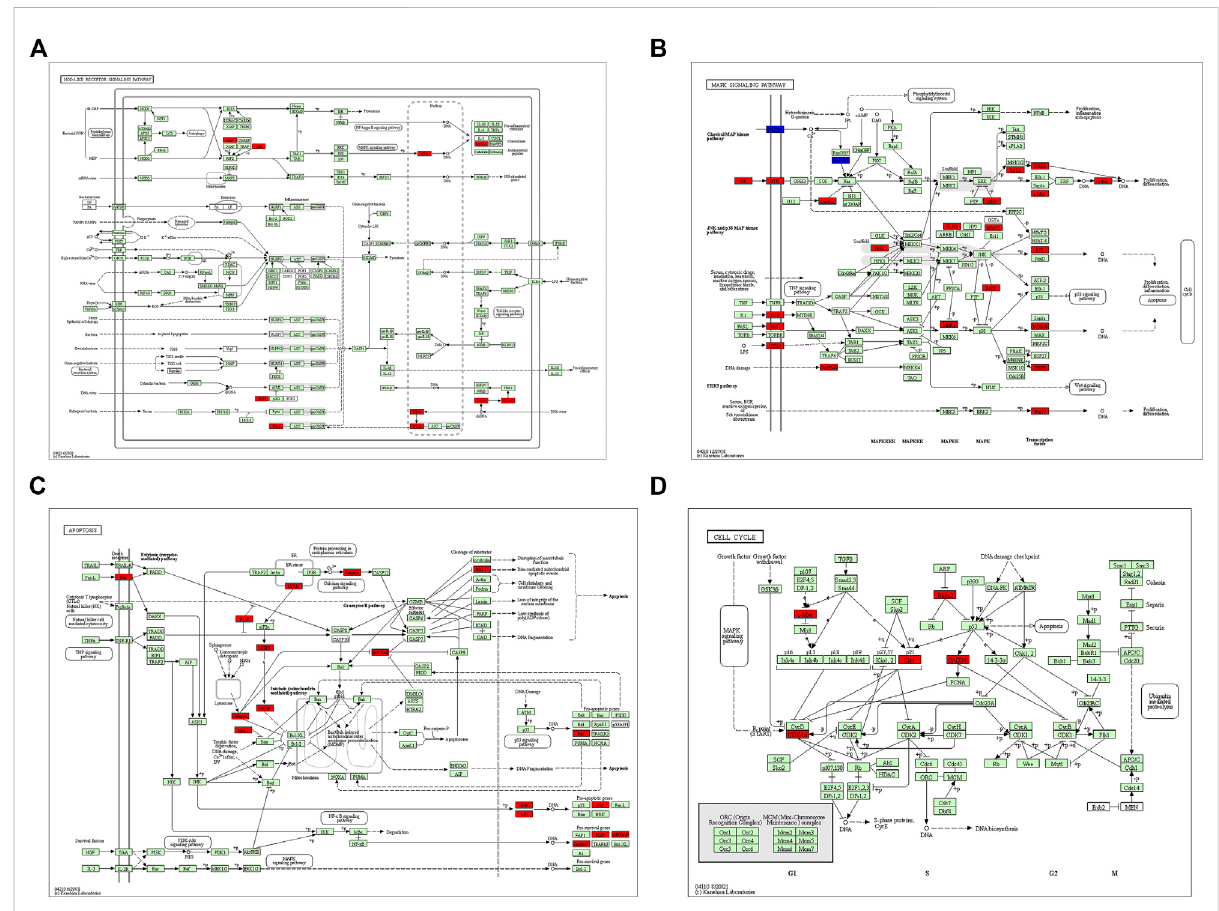
FIGURE 6 KEGG pathway enriched by common differential genes. (A) NOD-like receptor signaling pathway, (B) MAPK signaling pathway, (C) apoptosis signaling pathway, and (D) cell cycle signaling pathway. Note: genes marked in red in signaling pathways are expressed as differentially expressed genes in this